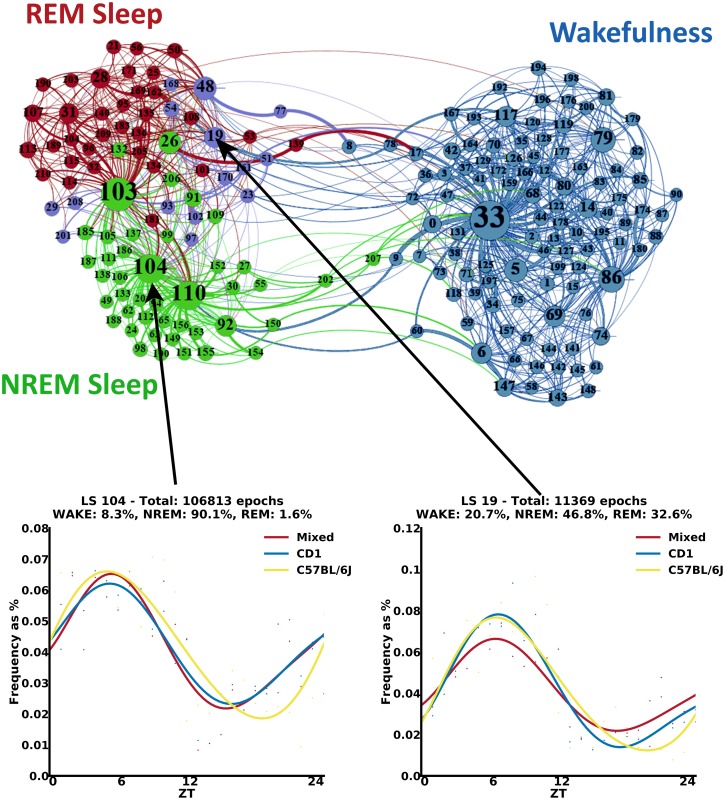
Transitions’ probabilities between substages and daily profiles analysis.Top: state-transition graph in which nodes have been clustered according to the transition probabilities. Nodes correspond to the substages, and edges identify the transitions between stages. Nodes’ size is related to their in-degree. Blue, green, and red nodes are associated with substages mapping with high probability to wakefulness, NREM sleep, and REM sleep, respectively. Purple nodes correspond to substages that do not have a clear mapping to 1 of the 3 known stages (probability lower than 0.6 for any stage). Edges’ weight is related to the corresponding transition probability, and their color is related to the source node. Graphs were built using the ForceAtlas2 algorithm [15,16] (see also interactive graphs at http://pavis.iit.it/datasets/mouse-sleep-analysis). Bottom: examples of daily profiles associated with NREM sleep, in which the profile of C57BL/6J mouse group is slightly shifted. Histograms describe the distribution of epochs using bins of 1 hour. Polynomial curves are fitted to the histograms to obtain a simplified visual representation of daily oscillations. LS, latent state; NREM, non-rapid eye movement; REM, rapid eye movement; ZT, zeitgeber time.